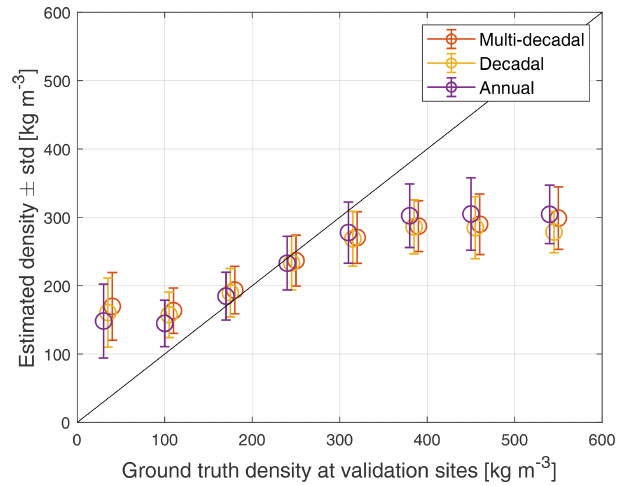
Figure 6. Comparison of multi-decadal, decadal, and annual density estimates. As can be observed, annual densities perform best for small and large density values.